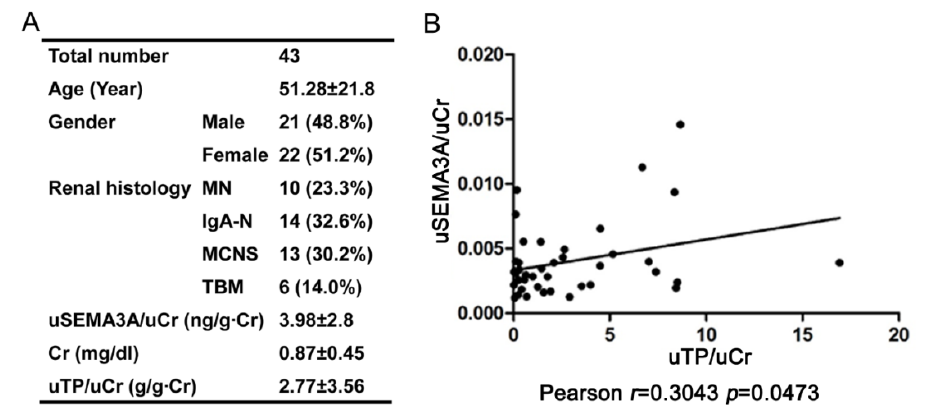
Figure 7. Positive correlation is present between urinary SEMA3A and proteinuria in human urine samples from biopsied patients. ( A ) Characteristics of the patients. Values are mean ± standard deviation (SD). Percentages are reported for categorical variables. Cr, serum creatinine; uCr, urinary creatinine; uTP, urinary total protein; uSEMA3A, urinary SEMA3A; IgA-N: IgA nephritis; MN, membranous nephropathy; TBM, thin basement membrane disease; MCNS, minimal change nephrotic syndrome. ( B ) The relationship between the uSEMA3A / uCr ratio (ng / g Cr) and uTP / uCr ratio (g / g · Cr) are shown. uSEMA3A level was positively correlated with urine protein ( n = 43). r = 0.3043, p = 0.0473.